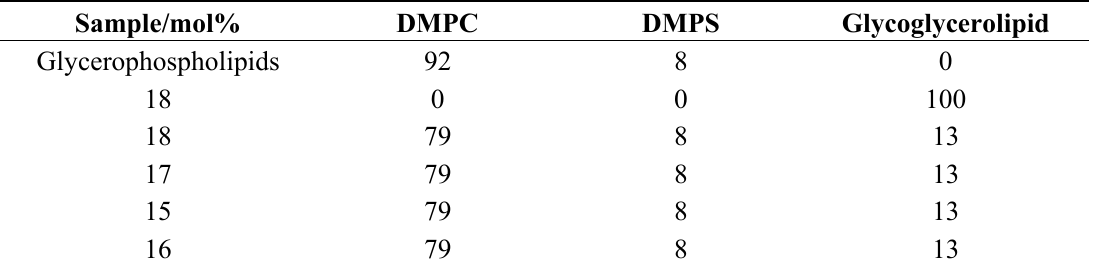
Table 2. Composition of the lipid vesicle samples used for DSC studies in this